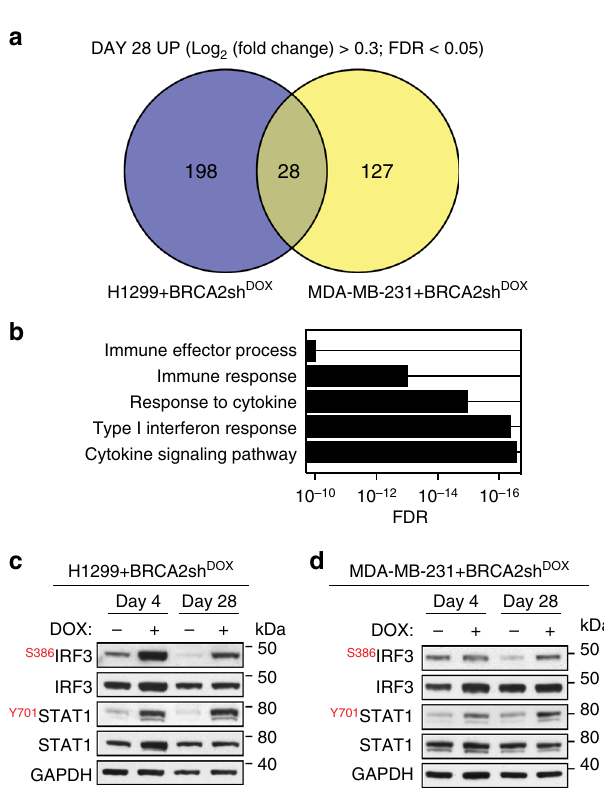
Fig. 3 Upregulation of innate immune response genes in BRCA2-de fi cient human cells. a Venn diagram of common genes upregulated in H1299 and MDA-MB-231 human cells, upon chronic (28 days) DOX-induced BRCA2 depletion. b Gene set enrichment analysis (Gene Ontology — Biological Process database) of the 28 genes upregulated upon chronic BRCA2 inactivation in both H1299 and MDA-MB-231 cells. c , d Whole-cell extracts prepared after 4 and 28 days of DOX treatment were immunoblotted as indicated. GAPDH was used as a loading control. Phosphorylation site